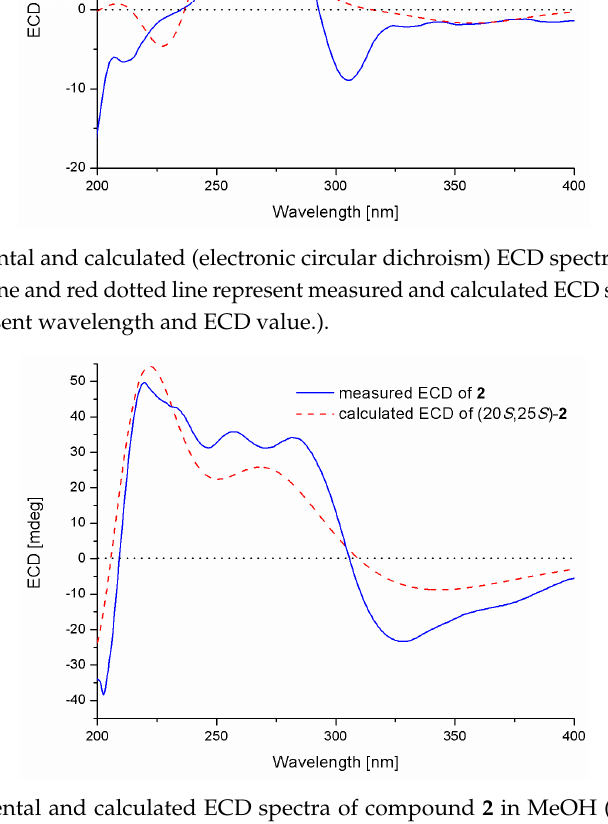
Figure 4. Experimental and calculated ECD spectra of compound 2 in MeOH (Blue solid line and red dotted line represent measured and calculated ECD spectra, respectively; X- and Y-axis represent wavelength and ECD value.).